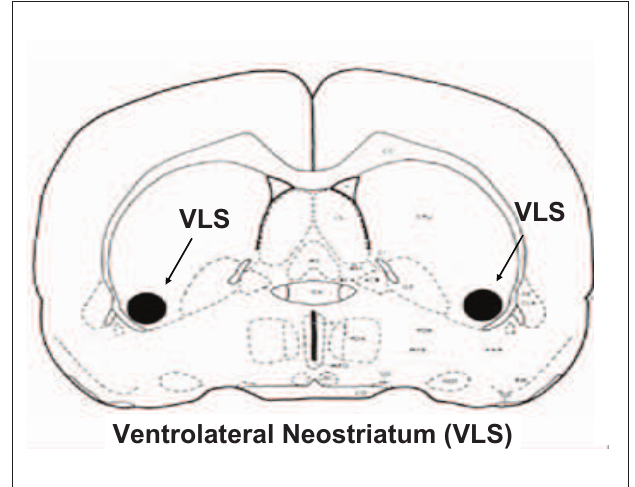
Figure 3 | Drawing of coronal section from rat brain, modified from Pellegrino et al. (1979) to show location of the ventrolateral neostriatum (VLS), which is a critical striatal subregion at which DA, ACh, and adenosine receptor mechanisms interact to regulate tremulous jaw movements (see text for